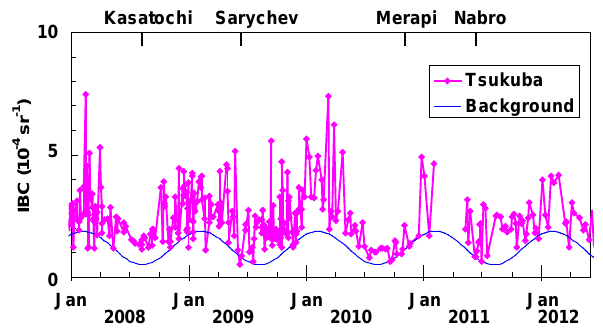
Fig. 8. Temporal variation of IBC from the first tropopause to an altitude of 33km (pink solid diamond) over Tsukuba from January 2008 through May 2012. The blue line represents the seasonal vari- ation of the monthly averaged IBC for background stratospheric aerosols observed at Tsukuba during October 1997 through Septem- ber 2001. The date of each volcanic eruption is shown on the upper horizontal